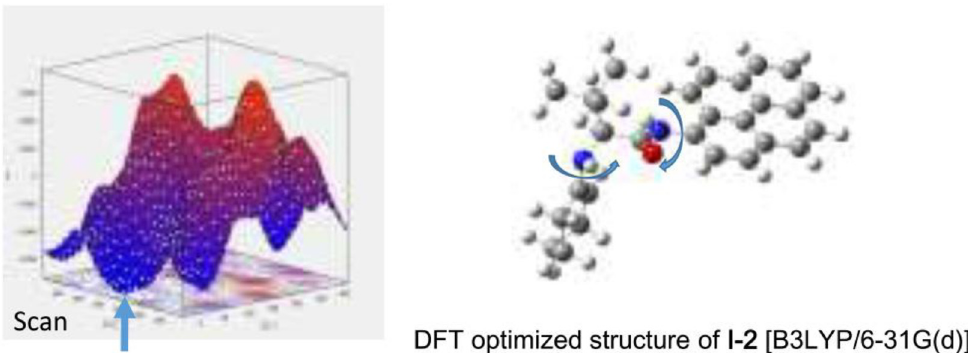
Figure 3. A scan of total energies of the intermediate ( I ) generated by varying two torsion angles (dihedral scans represented with u-shaped arrows, as shown in the right structure). The arrow at the bottom represents the global energy minimum conformer (in the left figure). Reprinted with permission from Ref. [70]. Copyright 2018, Elsevier.